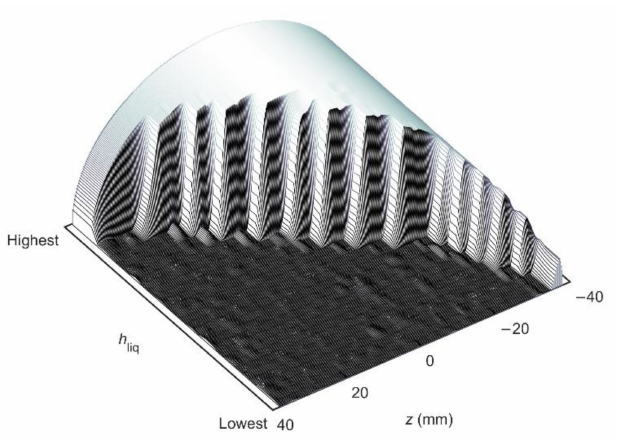
Figure 12. The set of 1D liquid distribution images acquired in the static verification experiments represented as a surface plot in which liquid distribution images are sorted from the highest to lowest measured holdup. The axis labeled as z indicates the height along the flow tube with the pipe axis located at z = 0 mm. The separate experiments are well recognized as steps in the surface as a progressively bigger portion of the semi-circle is cut-off due to the absence of